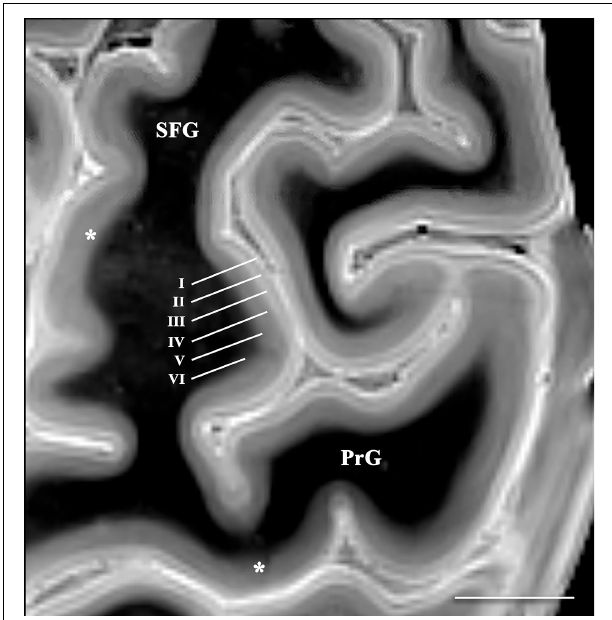
FIGURE 4 | Axial image of the frontal cerebral cortex near the superior convexity of the left hemisphere (PrG, precentral gyrus; SFG, superior frontal gyrus) [scale bar = 10 mm]. T2 SPACE images with 400-micron isotropic voxels provide adequate spatial and contrast resolution to visualize horizontal cortical layers (annotated along the lateral bank of the superior frontal gyrus). The layers vary in signal intensity and thickness. Contrast discrimination of the deeper layers (particularly layer V) is diminished in the primary and supplementary motor cortices (*).